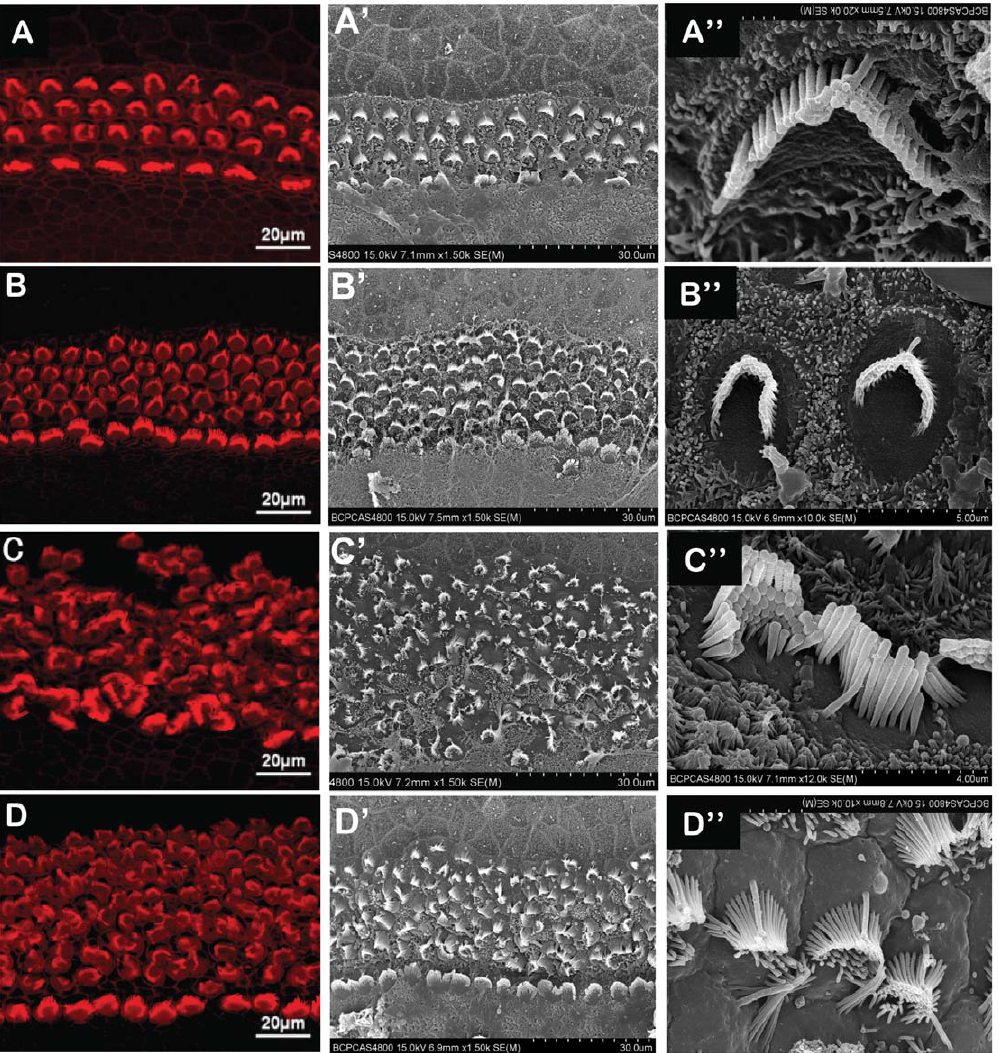
Figure 6. DAPT treatment changed the orientation of the stereocilia bundle of the cultured hair cells. A, B, C, D: the laser scanning confocal microscope image of the hair bundle on the hair cell (phalloidin staining); A 9 , B 9 , C 9 , D 9 : Scanning electron microscope image of the cultured hair cells; A and A 9 : without treatment, the stereocilia and hair cells bundle kept in order. B and B 9 : Atoh1 over expression group, the hair cell increased and their stereocilia bundles still kept relatively tidy. C and C 9 : Treated with DAPT, the orientation of the stereocilia bundle changed dramatically. The hair cells were out of order. D and D 9 : DAPT + Atoh1 over expression, the stereociliary bundles were more untidy than control and solely Atoh1 over expression but tidier than that of treated solely with DAPT. A 0 , B 0 , C 0 , D 0 : Stereocilia bundle of an outer hair cell in the control group, Atoh1 over expression group, DAPT and DAPT + Atoh1 group separately.